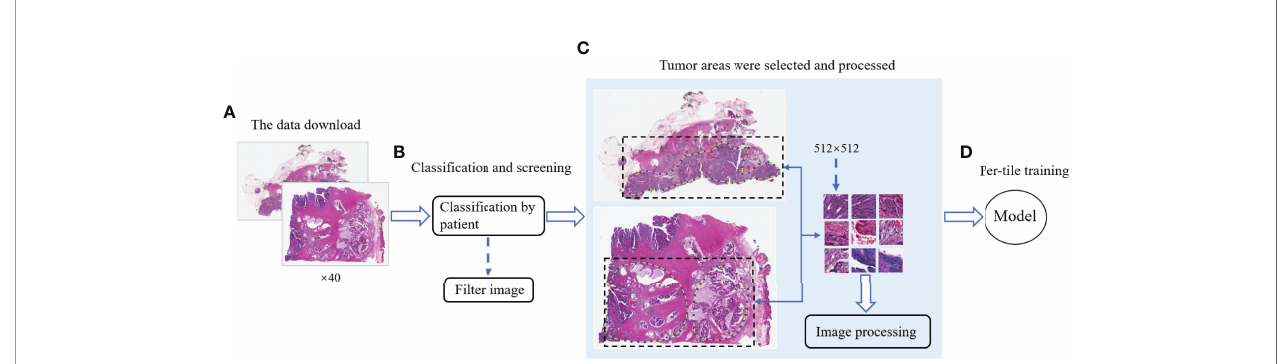
FIGURE 1 | The work fl ow of this study. (A) Download the CRC image data of ×40 resolution from TCGA. (B) Categorize the data by patients and remove the unquali fi ed images. (C) Mark the tumor area and segment it, and then perform noise removal and color normalization processing. (D) Model training